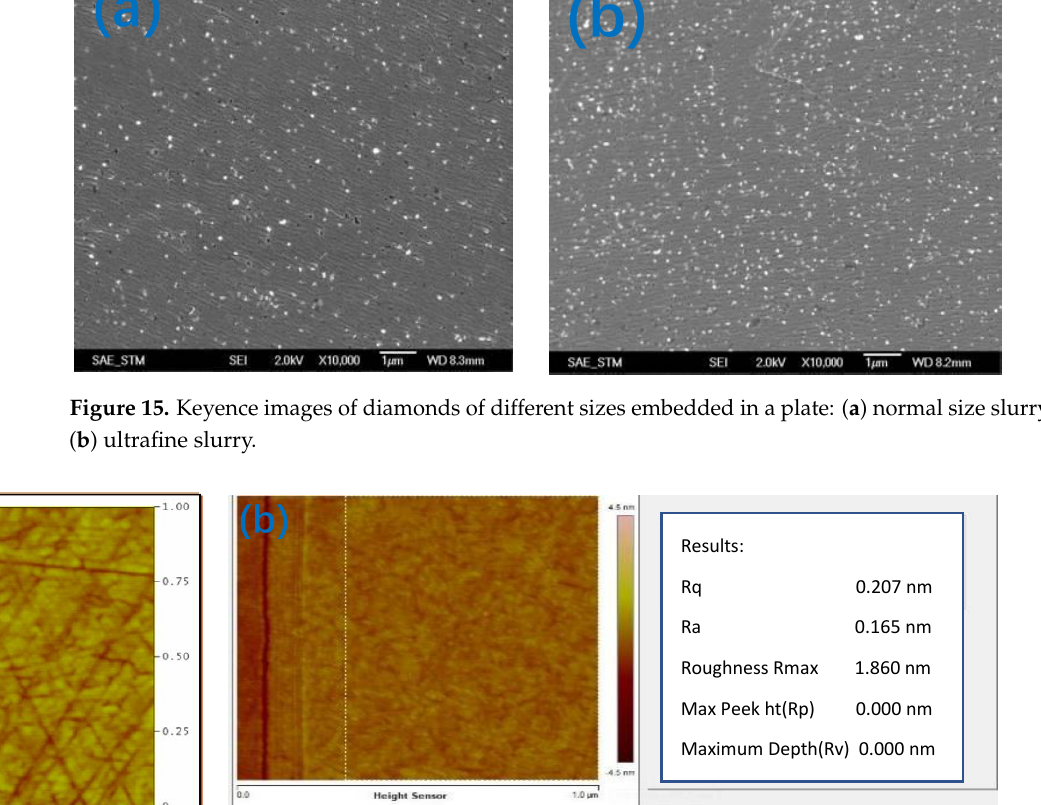
Figure 16. Comparison of AFM images of a slider surface produced under normal and improved conditions: ( a ) surface produced under normal conditions; ( b ) surface produced under improved conditions.